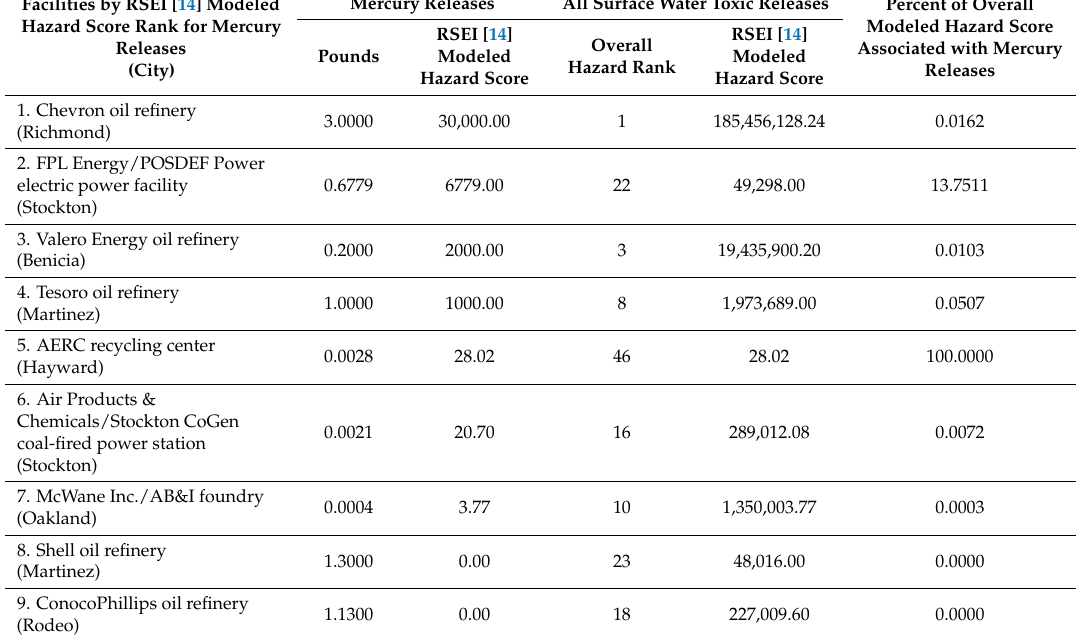
Table 4. Surface water toxic release facility ranked by RSEI [14] modeled hazard score for mercury releases and total releases, 2000–2006.